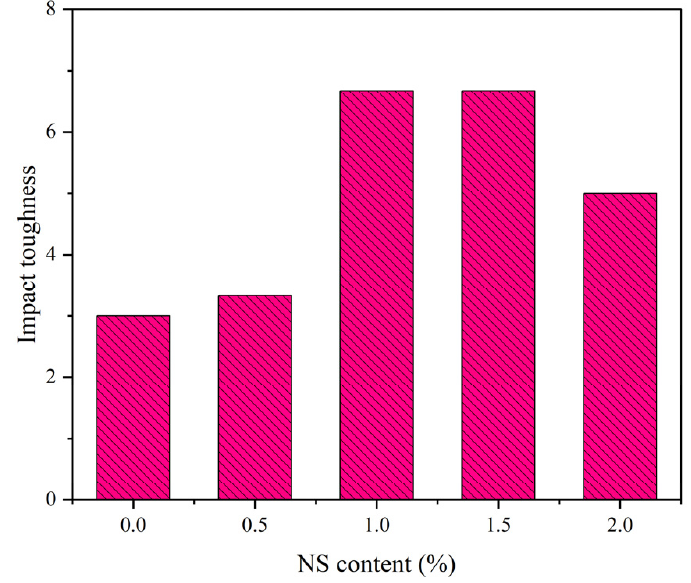
Figure 11. The impact toughness of NS–GPC.